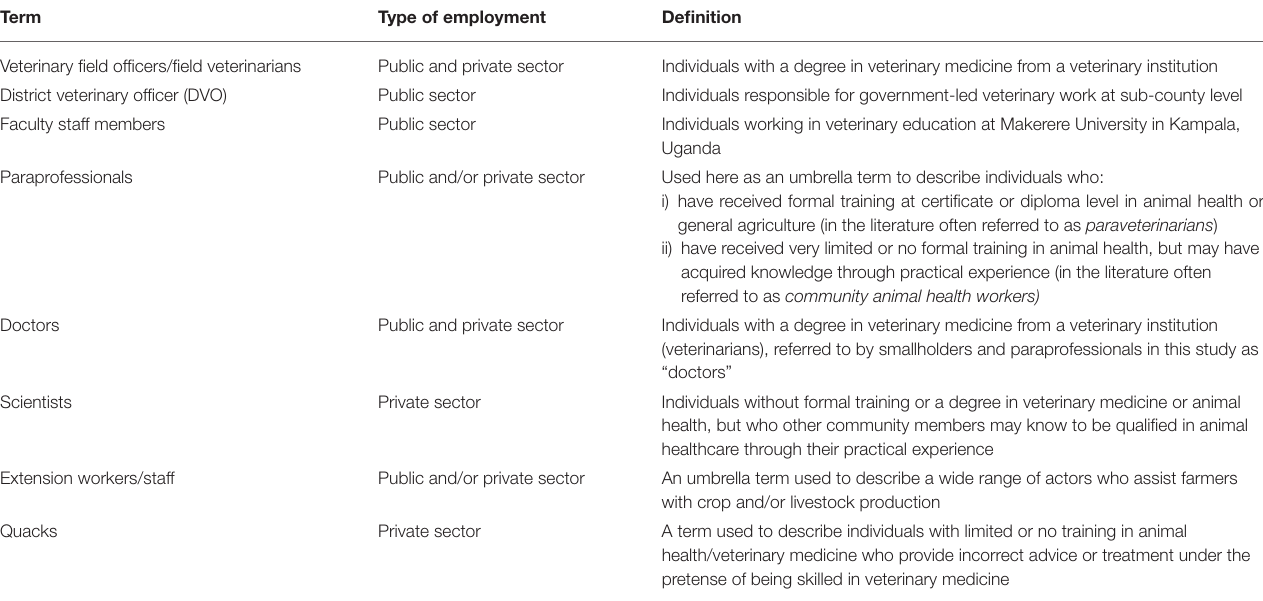
TABLE 2 | Description of formal and informal animal health service provider terms mentioned in this